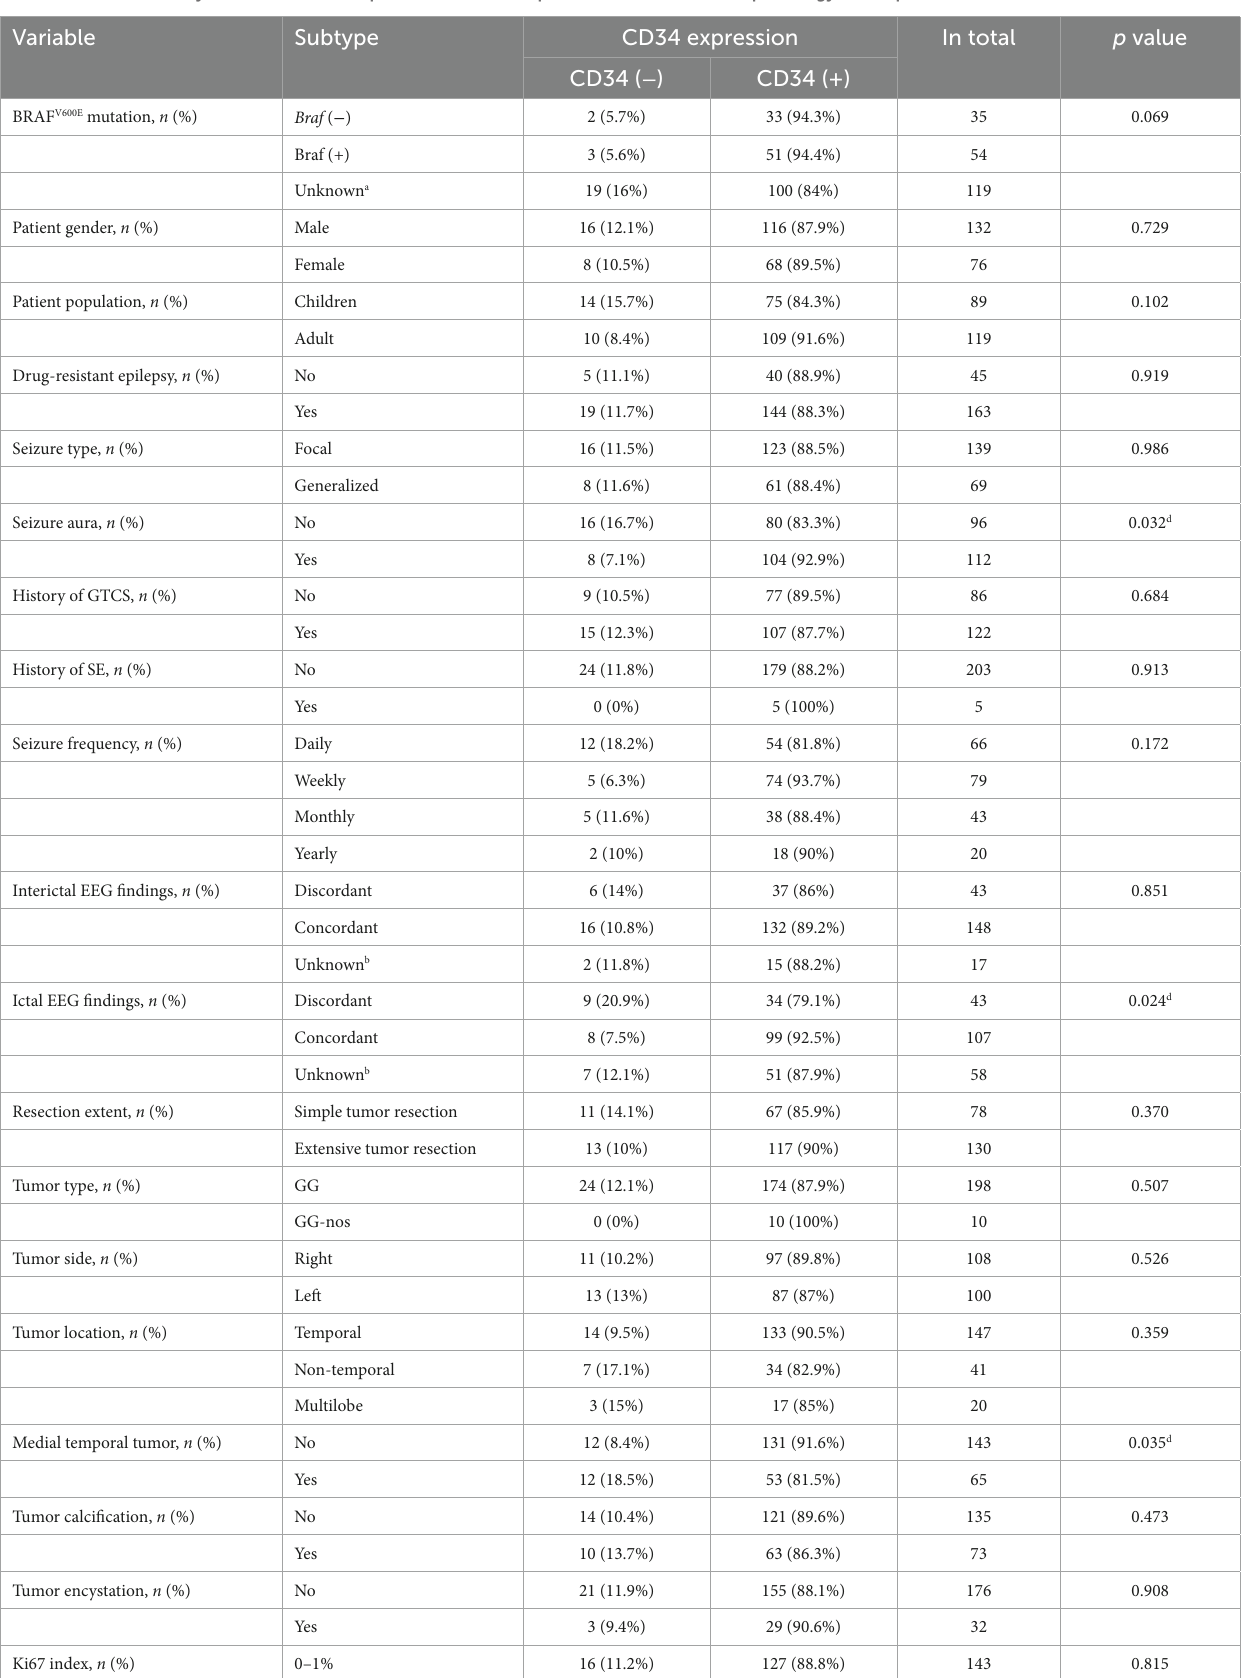
TABLE 1 Univariate analysis of the relationships between CD34 expression in GG and clinicopathology in 208 patients. Variable Subtype CD34 expression In total p value CD34 ( − ) CD34